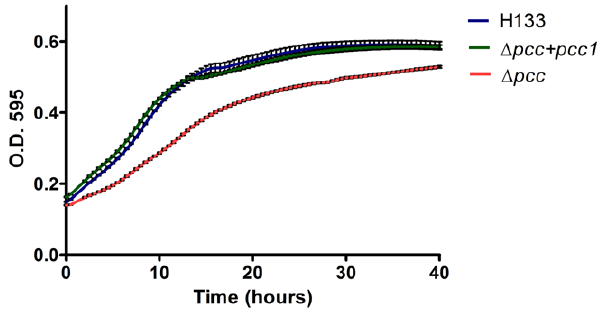
Figure 1. Growth of wild type Haloferaxvolcanii and the D pcc1 mutant cells. Growth curves comparing the growth rate of H133 (wild- type), D pcc1 (HAN16) and D pcc1 containing the complementing plasmid (HAN19). Results are a mean of 10 replicates, error bars indicates standard error of the mean.